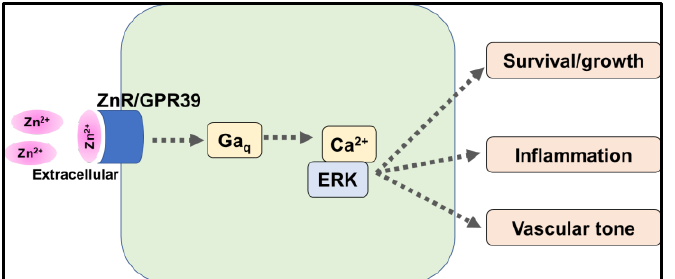
Figure 5. Pathway of intracellular activity by zinc signal via ZnR/GPR39. Zinc signaling via ZnR/GPR39 activates MAPK/ERK via Gαq, which is involved in cell survival and proliferation, ZnR/GPR39 activates MAPK/ERK via G α q, which is involved in cell survival and proliferation, angiogenesis, inflammatory responses, and vascular tone. angiogenesis, inflammatory responses, and vascular